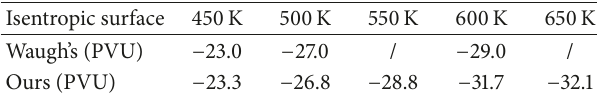
Table 1: Values of criterion PV contour used to define the edge of the Antarctic